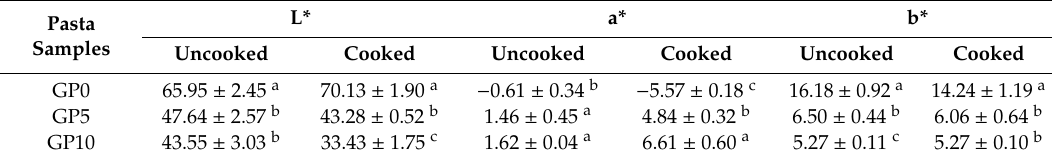
Table 2. Color analysis of uncooked and cooked control pasta (GP0) and pasta fortified with di ff erent percentages of grape pomace (GP5 and GP10). The data, reported as mean ± standard deviation, are expressed as L*, a*, and b*